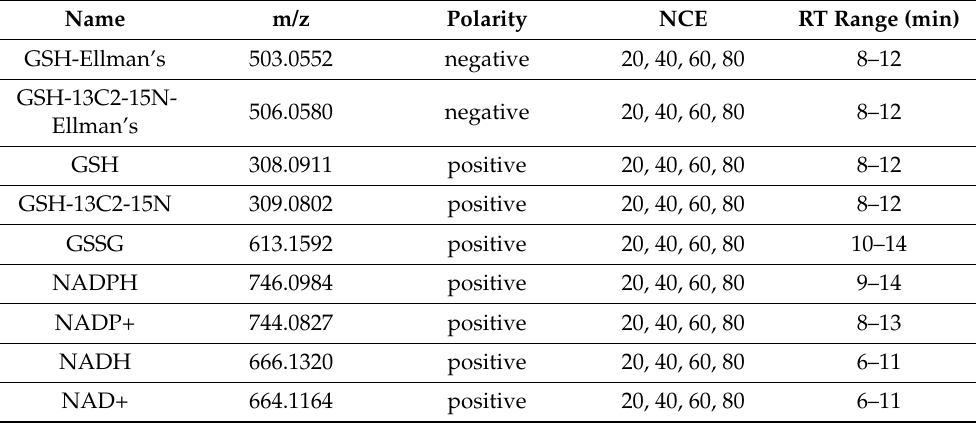
Table 6. Inclusion list for PRM analysis of specified metabolites.